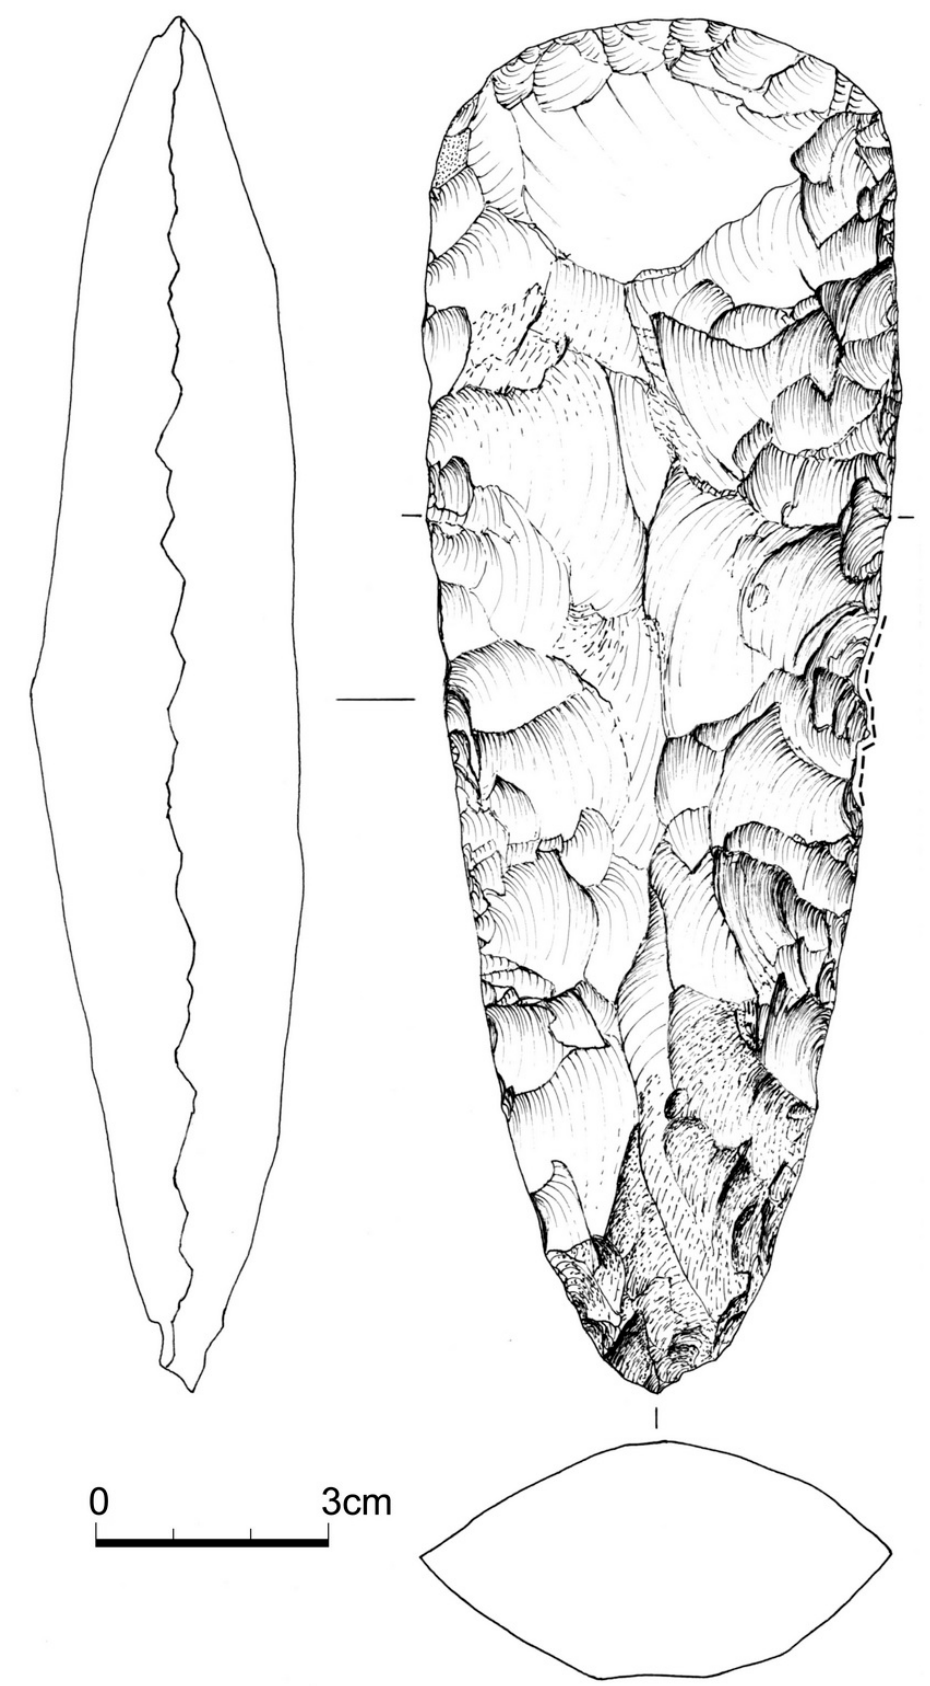
Figure 26. Petit-Spiennes. Flaked axehead (ST 20 shaft). Drawing by A.-M. Wittek,